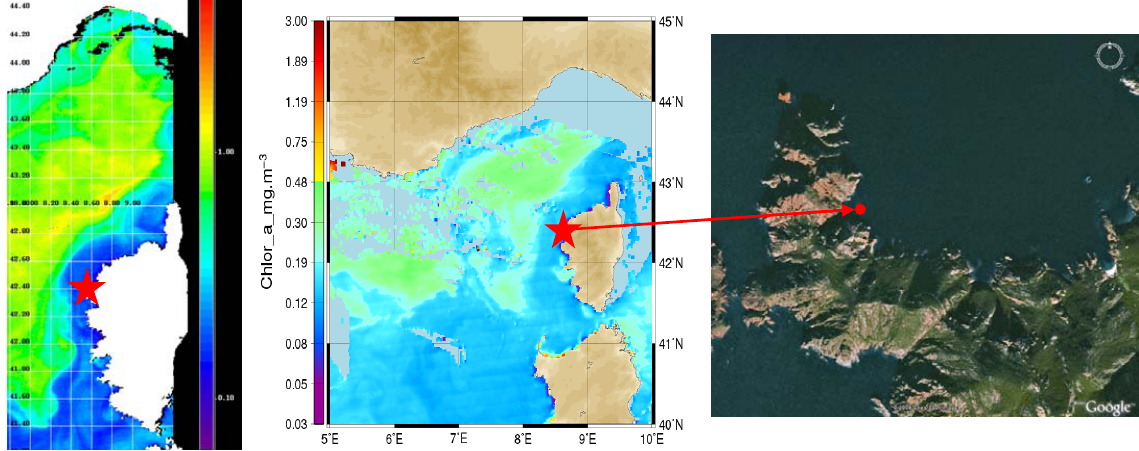
Fig. 1. MODIS satellite image showing the chlorophyll- a distribution in the Ligurian Sea during the spring bloom (left image, 1 May 2008) and during the DUNE-1 experiment (central image, 16 June 2008); the DUNE mesocosm site in Scandola reserve on the coast of Corsica is marked in red: the site is characterized by “blue” waters typical of oligotrophic systems (source: MODIS, Nasa, E. Bosc, personal communication, 2008). The area chosen is a very “blue” area because of the uplift of the Ligurian Current along the Corsican coast that isolates the coastal area from more productive waters of the center of the Ligurian Sea: during both experiments, the waters were typical of oligotrophic conditions. The GoogleEarth® satellite image on the right shows the local configuration of the bay, protected from dominant westerly winds and swell by a